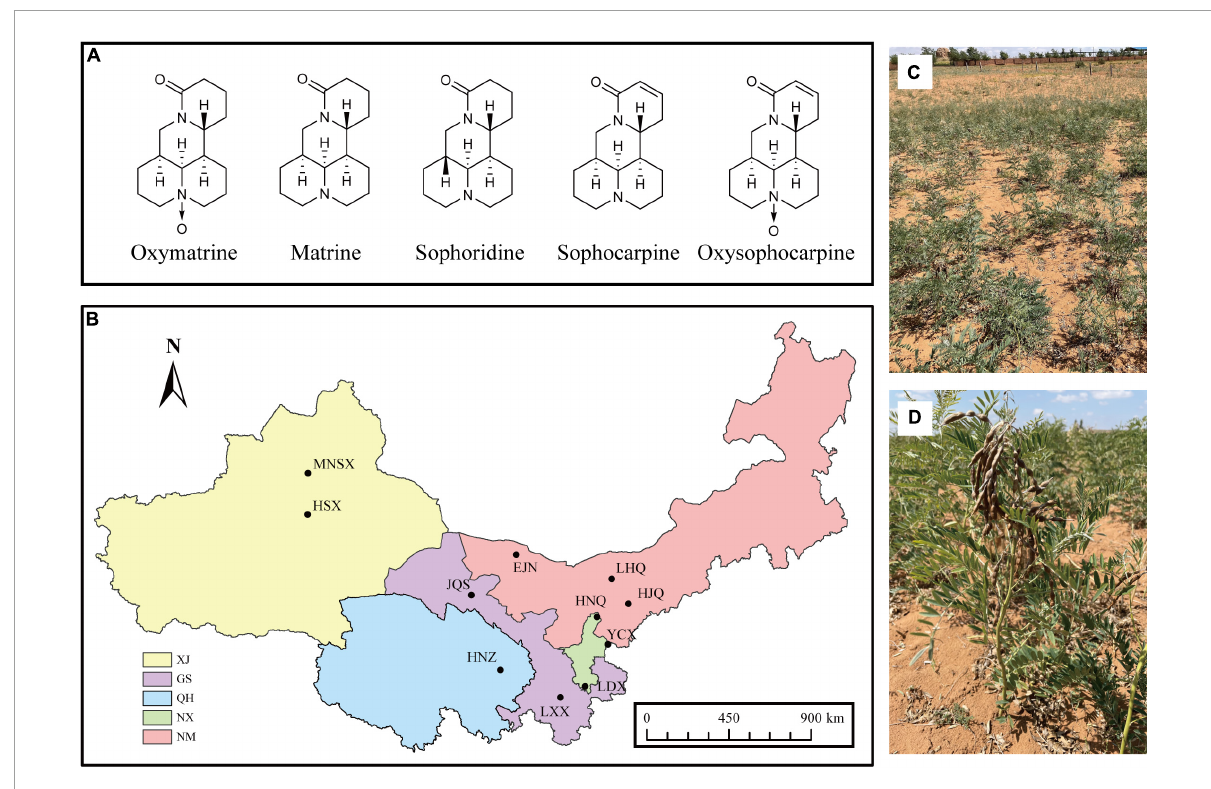
FIGURE1 (A) Chemical structures of the five quinolizidine alkaloids from S. alopecuroides , (B) distribution map of sampling plot of S. alopecuroides . XJ, Xinjiang Autonomous Region, GS, Gansu Province, QH, Qinghai Province, NX, Ningxia Autonomous Region, NM, Inner Mongolia Autonomous Region. (C,D) Habitat and plants of S. alopecuroides (photographed in Yanchi County, Ningxia,